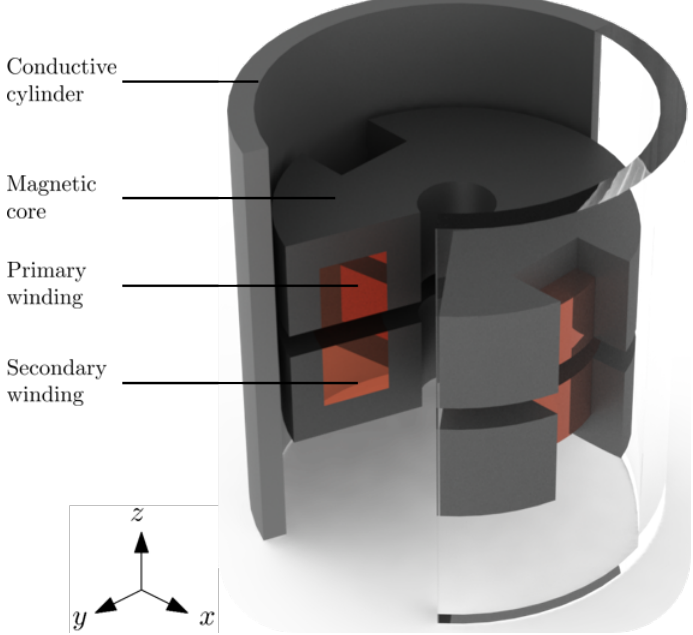
Figure 1. Overview of the investigated domain in three-dimensional space; pot core transformer confined by a conductive